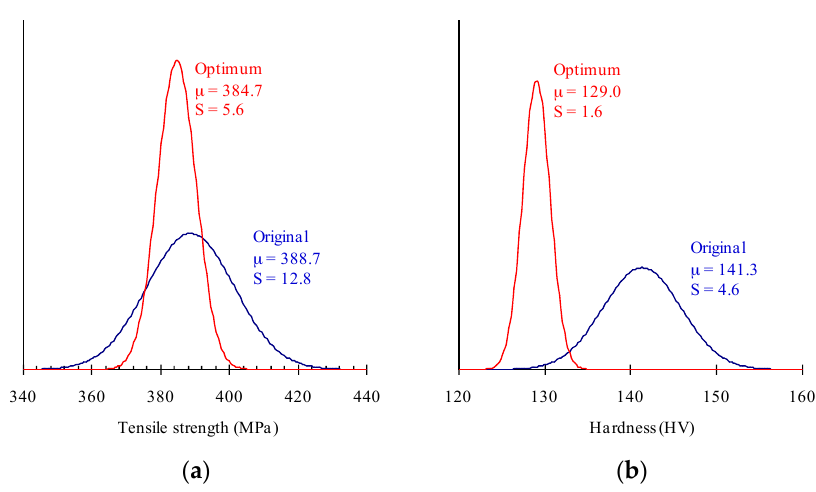
Figure 4. The probability distribution diagram for ( a ) tensile strength; ( b ) hardness.